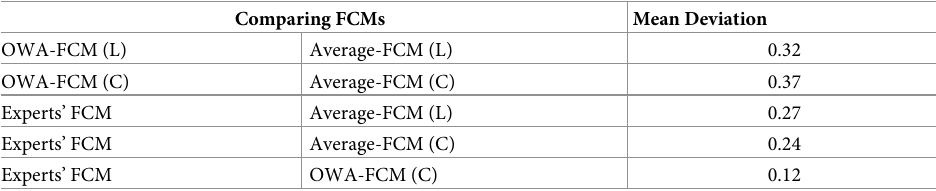
Table 2. Mean deviations among the aggregated